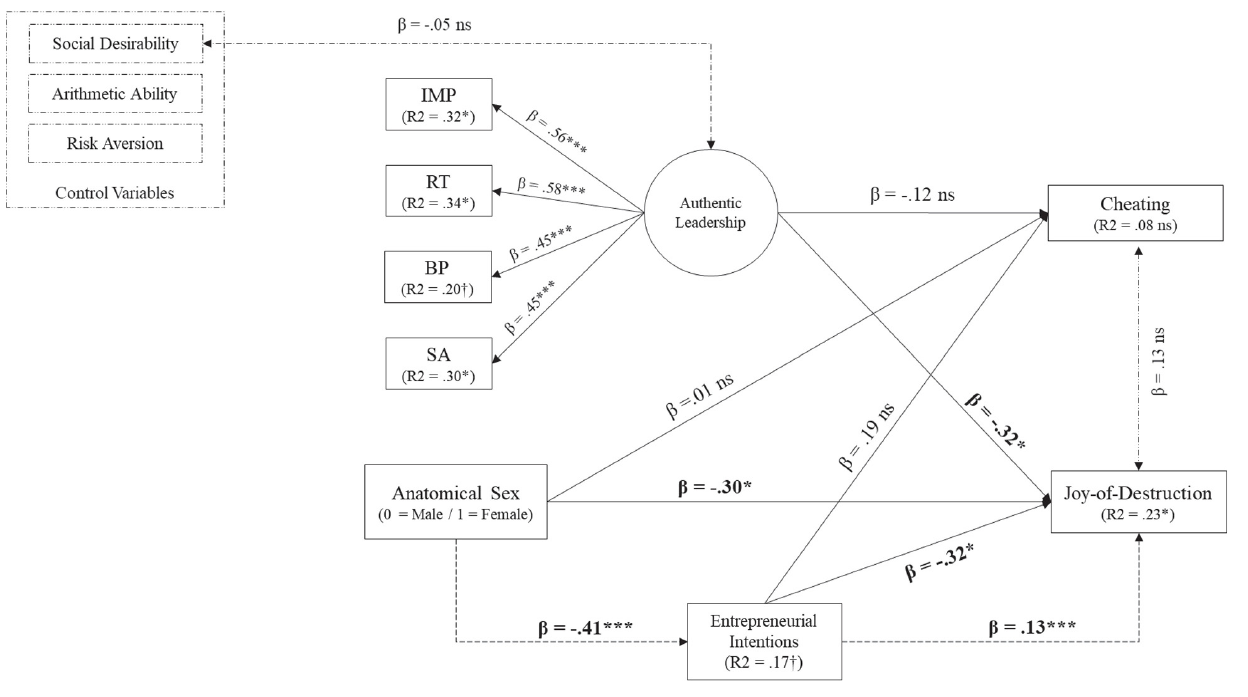
FIGURE 2 | Phase 1 – Revised main and indirect effects model. *** p < 0.0001; * p < 0.05; † p < 0.10; ns = non-significant.